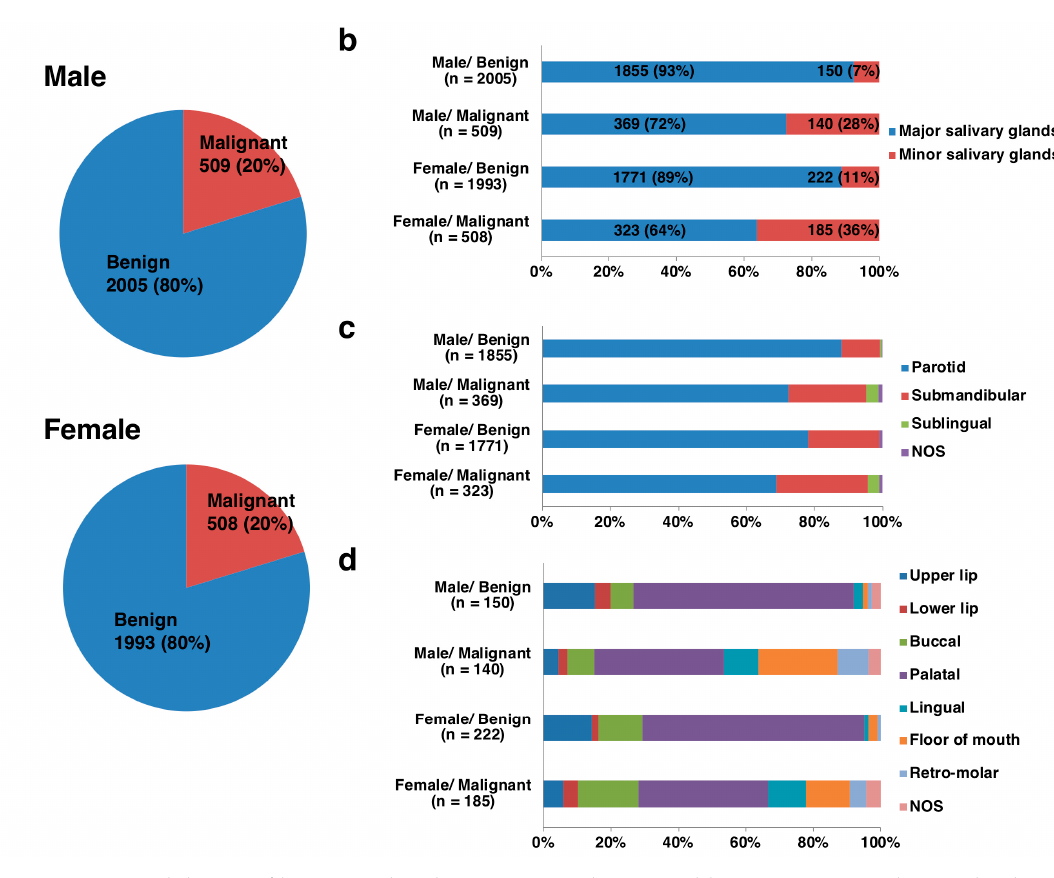
Figure 1. Breakdowns of benign and malignant tumors by sex and location in 5015 salivary gland tumors ( a , b ); 4318 major salivary gland tumors ( c ); and 697 minor salivary gland tumors ( d ). NOS: not otherwise specified.